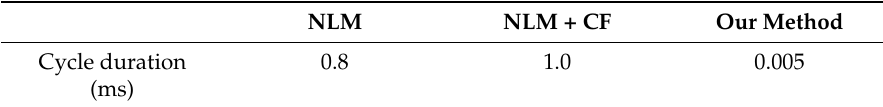
Table 3. Analysis of computational load.